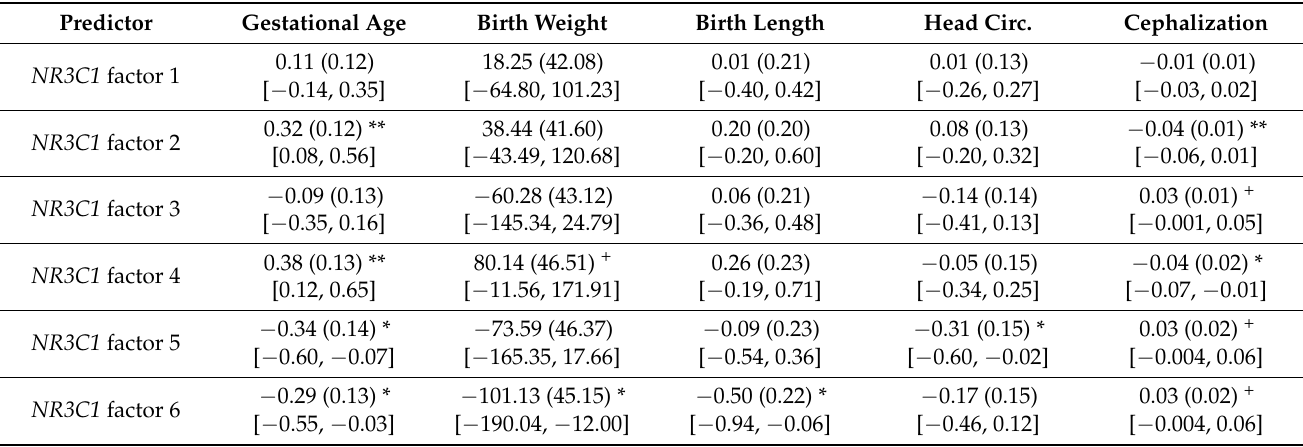
Table 3 lists the multivariable linear regression models testing the association between each NR3C1 DNA methylation factor score with infant outcomes. Differential patterning was observed for NR3C1 factor scores and infant outcomes. Higher NR3C1 scores for factors 2 and 4 were significantly associated with longer gestations, less cephalization, and marginally higher birth weight (factor 4). Higher NR3C1 scores for factors 5 and 6 were associated with shorter gestations, lower birth weights and increased cephalization. NR3C1 factors 1 and 3 were not significantly associated with any infant outcome. Table 3. Multivariable linear regression models testing the association between each NR3C1 DNA methylation factor score with infant outcomes